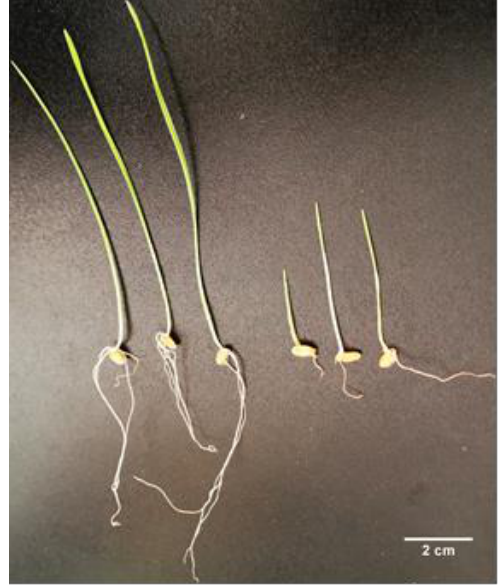
Figure 2. Effect on the growth of common wheat seeds (Triticum Aestivum). The three plants on the left were grown in the control condition, and the ones on the right in the presence of Pb.